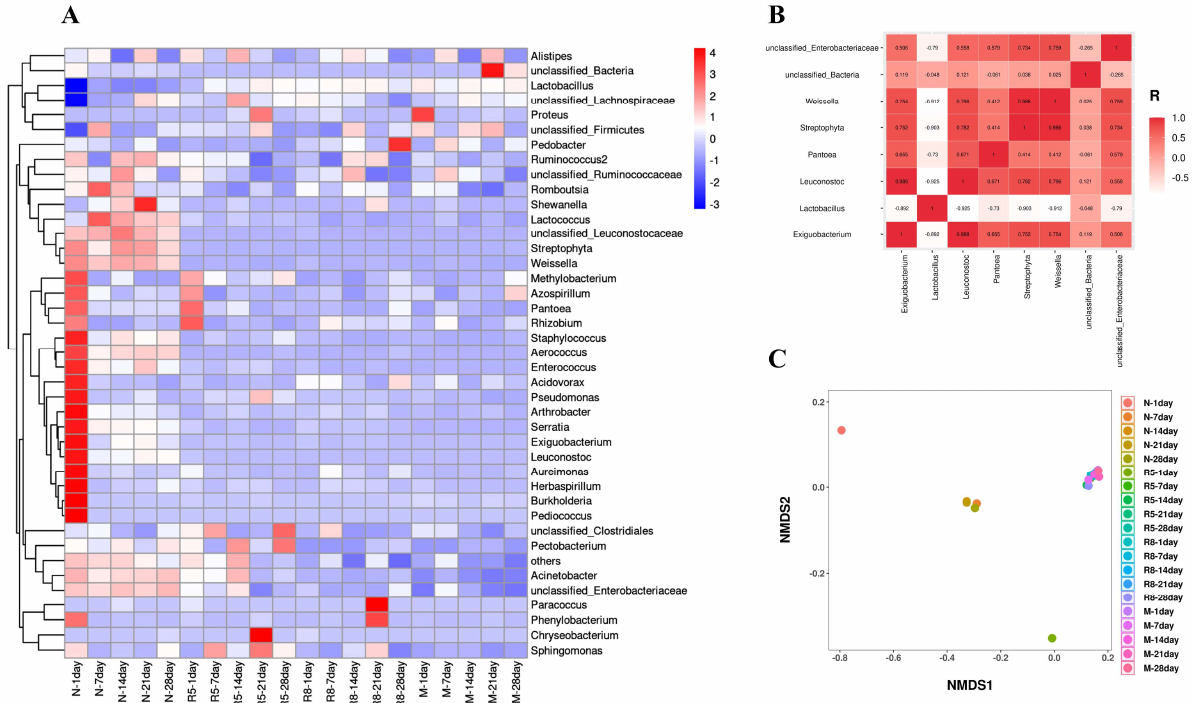
Figure 8. Heatmap of bacterial diversity at the genus level in different groups. ( A ) Correlation matrix of the Spearman’s rank correlation among the major genera. ( B ) The Spearman’s rank correlation coefficient ranges from 1.0 to −1.0, corresponding from strongly positive correlation to strongly negative correlation. NMDS analysis of bacterial community composition in pickle samples ( C ). Only the genus with an abundance >1% in at least one sample are shown here.